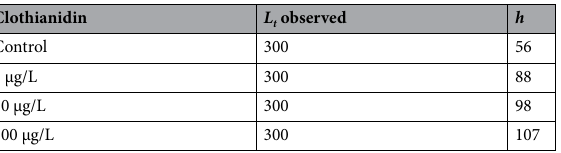
Table 1. Modeling of demographic compensation. In order to maintain a stable larval population (L t observed), colonies exposed to clothianidin would need to hatch more larvae per week than controls ( h denotes the number of eggs that hatch into larvae each week).